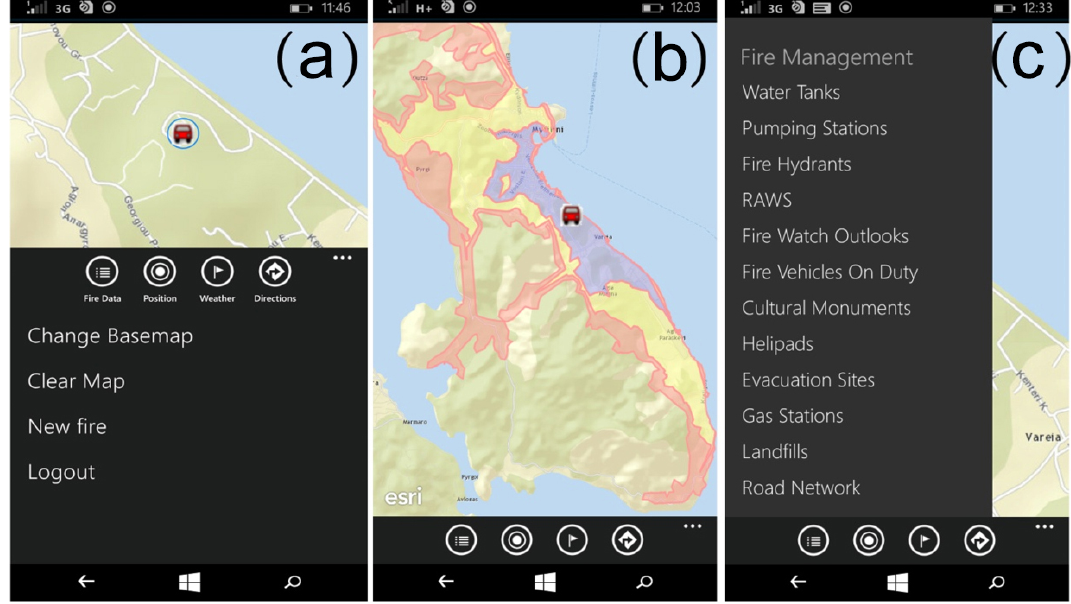
Figure 8. (a) Basic screen of AEGIS App; (b) calculation of the areas that the user can access by driving a regular firefighting truck in 3, 5 and 10min; and (c) accessing fire management data through the AEGIS